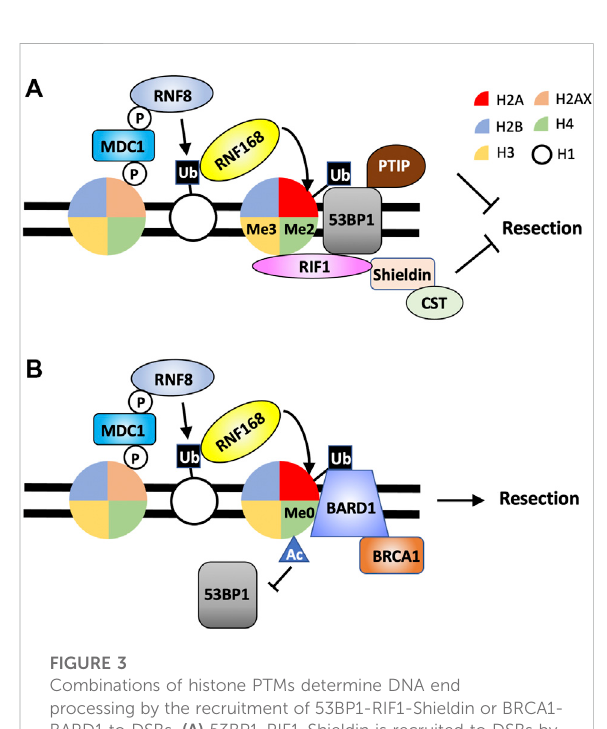
FIGURE 3 Combinations of histone PTMs determine DNA end processing by the recruitment of 53BP1-RIF1-Shieldin or BRCA1- BARD1 to DSBs. (A) 53BP1-RIF1-Shieldin is recruited to DSBs by H2AK15ub, H4K20me2 and H3K4me3. (B) BRCA1-BARD1 localizes to DSBS through the binding to H2AK15ub and H4K20me0. While H4K16Ac is not directly involved in promoting BRCA1-BARD1 recruitment to DSBs, it prevents the association of 53BP1 at damaged